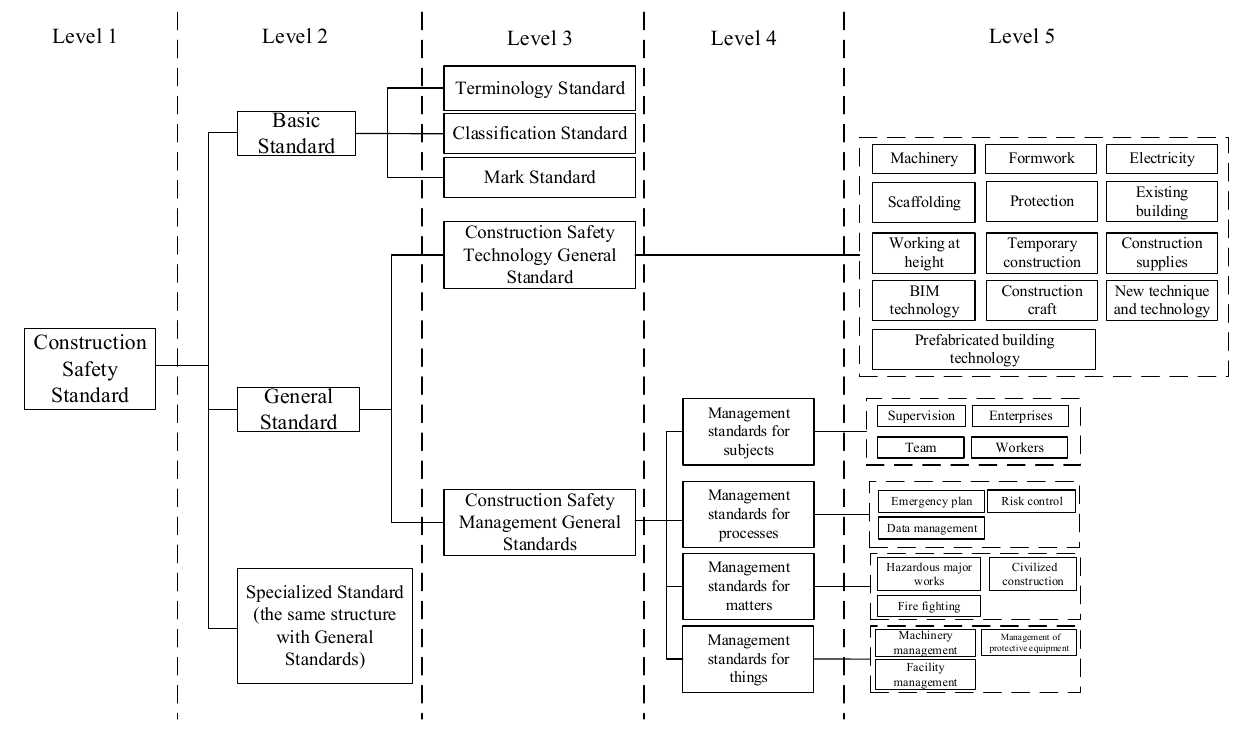
Figure 2. Conceptual layer framework of KGCSS.